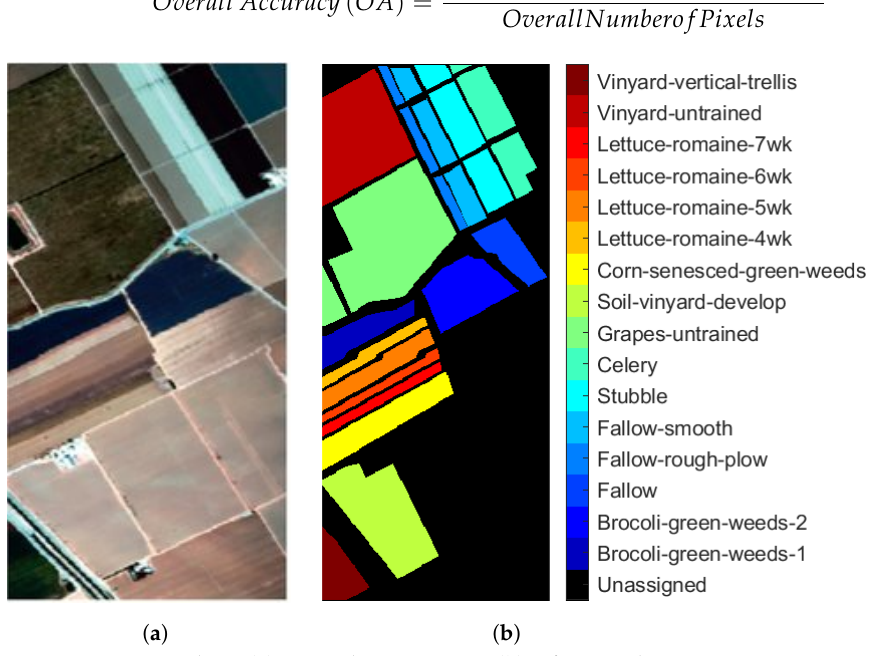
Figure 3. AVIRIS Salinas ( a ) true-color composite; ( b ) reference class map. Table 2. Groundtruth classes for SA scene and their respective samples number.